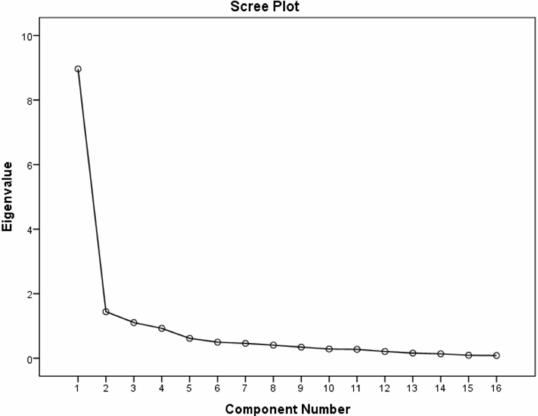
Figure 2. Scree Plot Graph for Pilot Study.